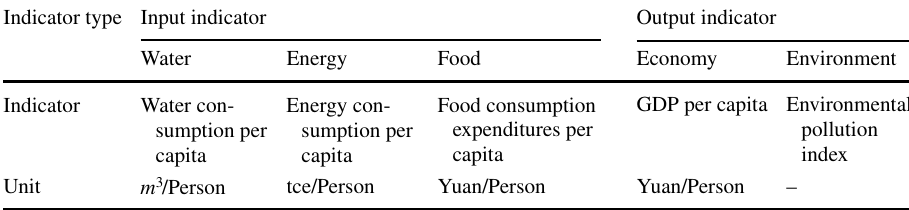
Table 10 W–E–F nexus input– output indicator